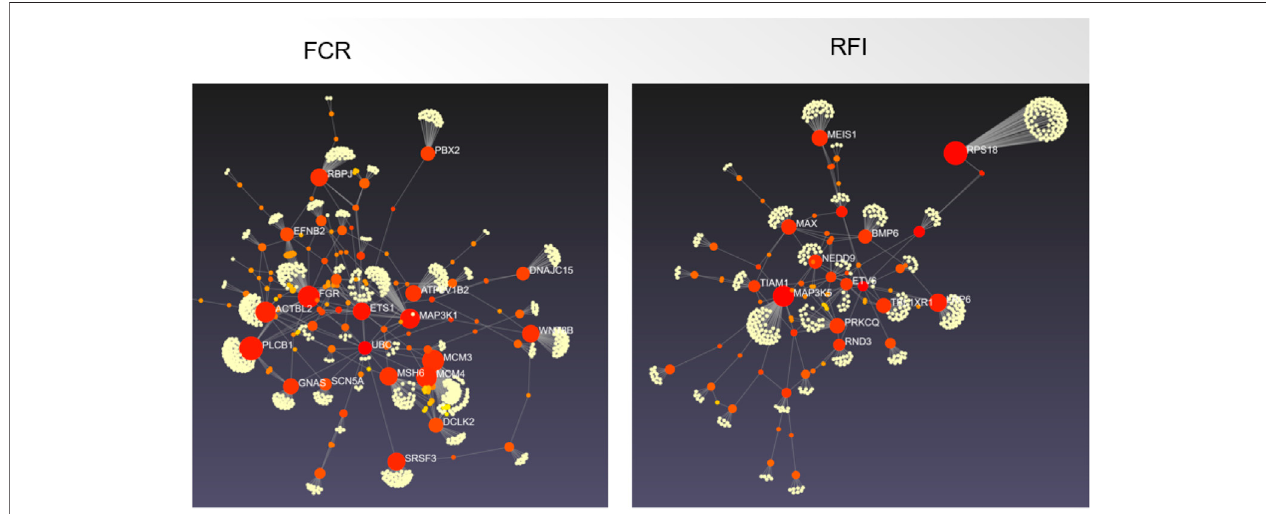
FIGURE 3 | The protein protein interaction networks for candidate genes for feed conversion ratio (left) and residual feed intake (right) in pig. The candidate genes from the pig QTL database and additional recent papers ( Supplementary Table S2 ) were used for building the interaction network using the default inputs of Network Analyst (Zhou et al.,